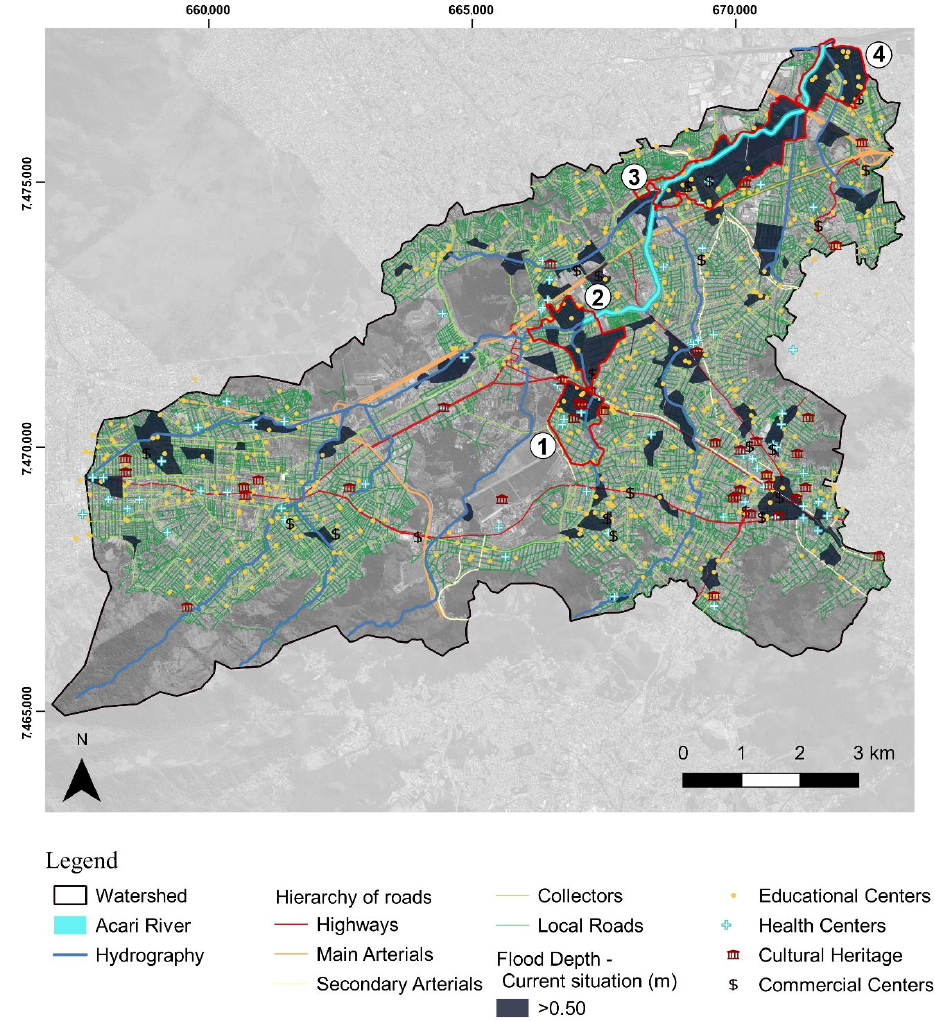
Figure 5. Impacts generated by floods on other systems for a return period of 25 years. The figure shows areas with more than 50 centimeters of flooding that configure a critical situation for the other systems.